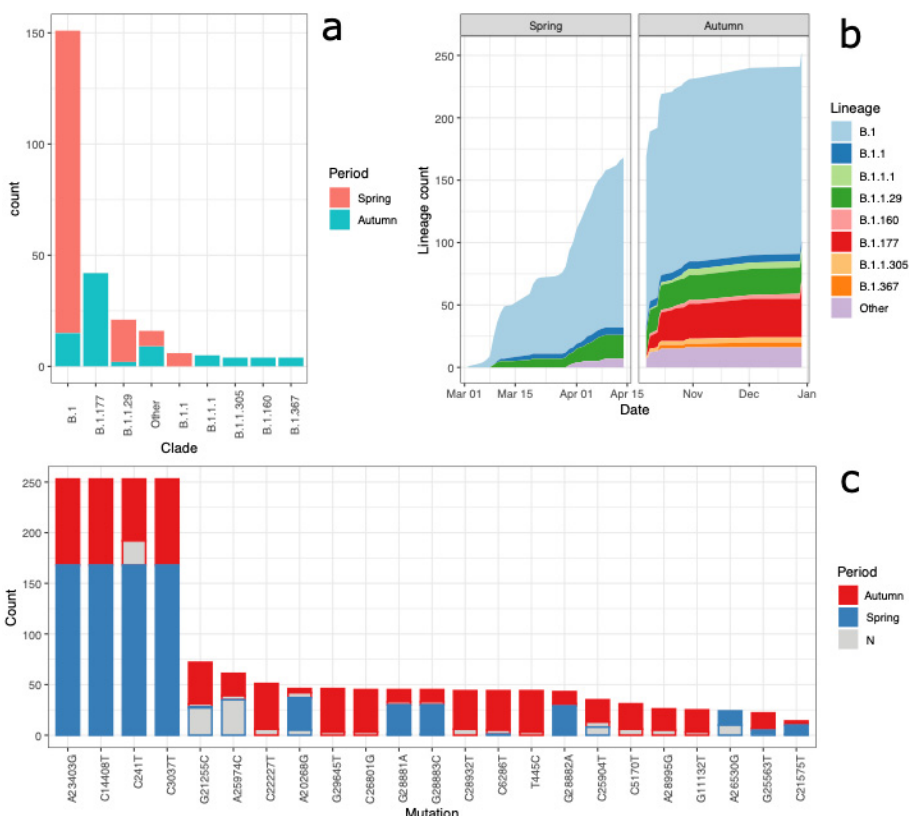
Figure 2. Frequency ( a ) and temporal distribution ( b ) of the Pangolin lineages in Trentino. ( c ) Most common mutations found in the first and second epidemic wave. In gray, we show the sequences where the mutation position was not sequenced. Only mutations present in more than 10 sequences are shown.